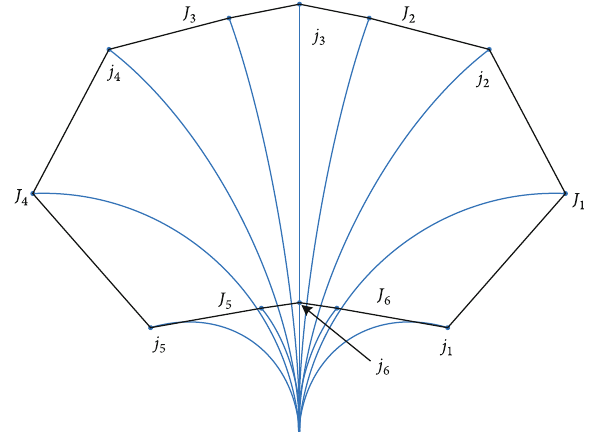
Figure 9: Landing footprints for Case 1.